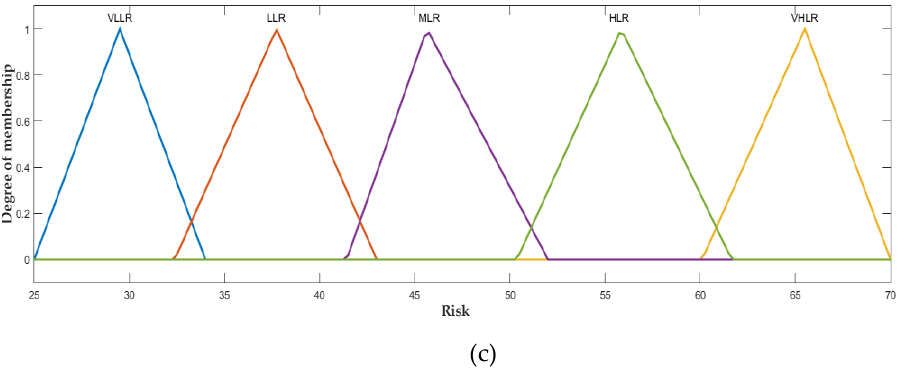
Figure 6. Input/output MFs for FIS_1 of the proposed CHFIS model, ( a ) leakage probability; ( b ) age; ( c ) risk.